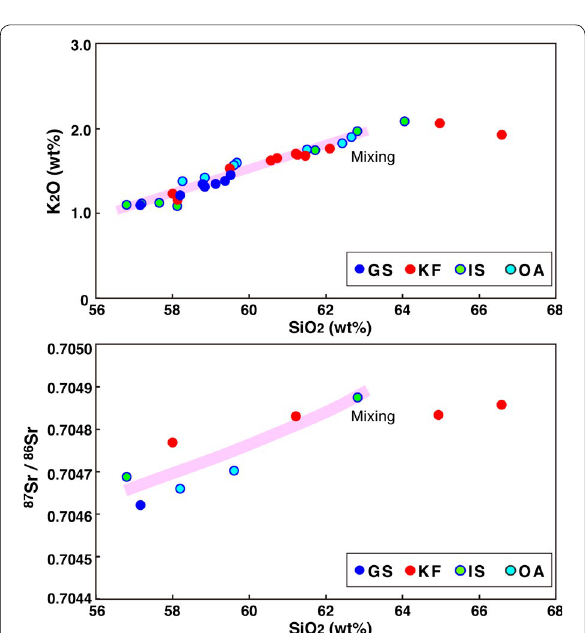
Fig. 17 K 2 O vs. SiO 2 and 87 Sr/ 86 Sr vs. SiO 2 diagrams for the products of Azuma-Jododaira Volcano. Abbreviations are same in Fig. 16. Data are from Yamamoto (2005) and this study (Additional file 3: Appendix